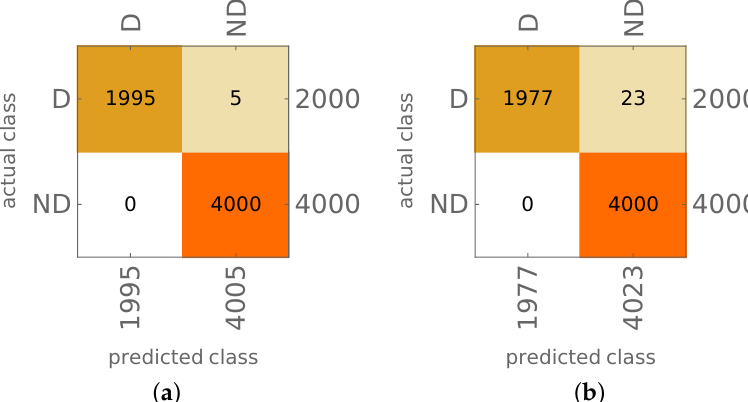
Figure 12. The results of CA model identification: ( a ) patterns used for CNN learning, 4 and 16 composite layers, ( b ) testing, 8 and 32 composite layers.